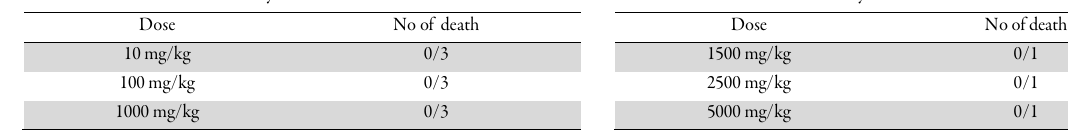
Table 2. Phase 1 of acute toxicity test Table 3. Phase 2 of acute toxicity test